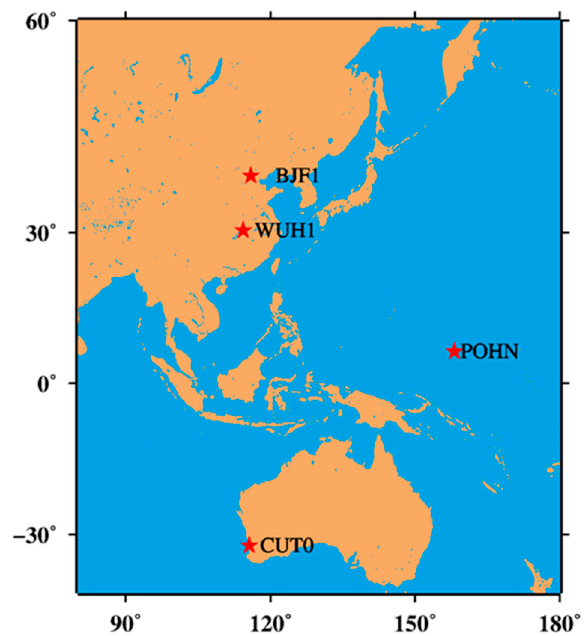
Figure 1. Distribution of the four selected global navigation satellite system (GNSS) stations.